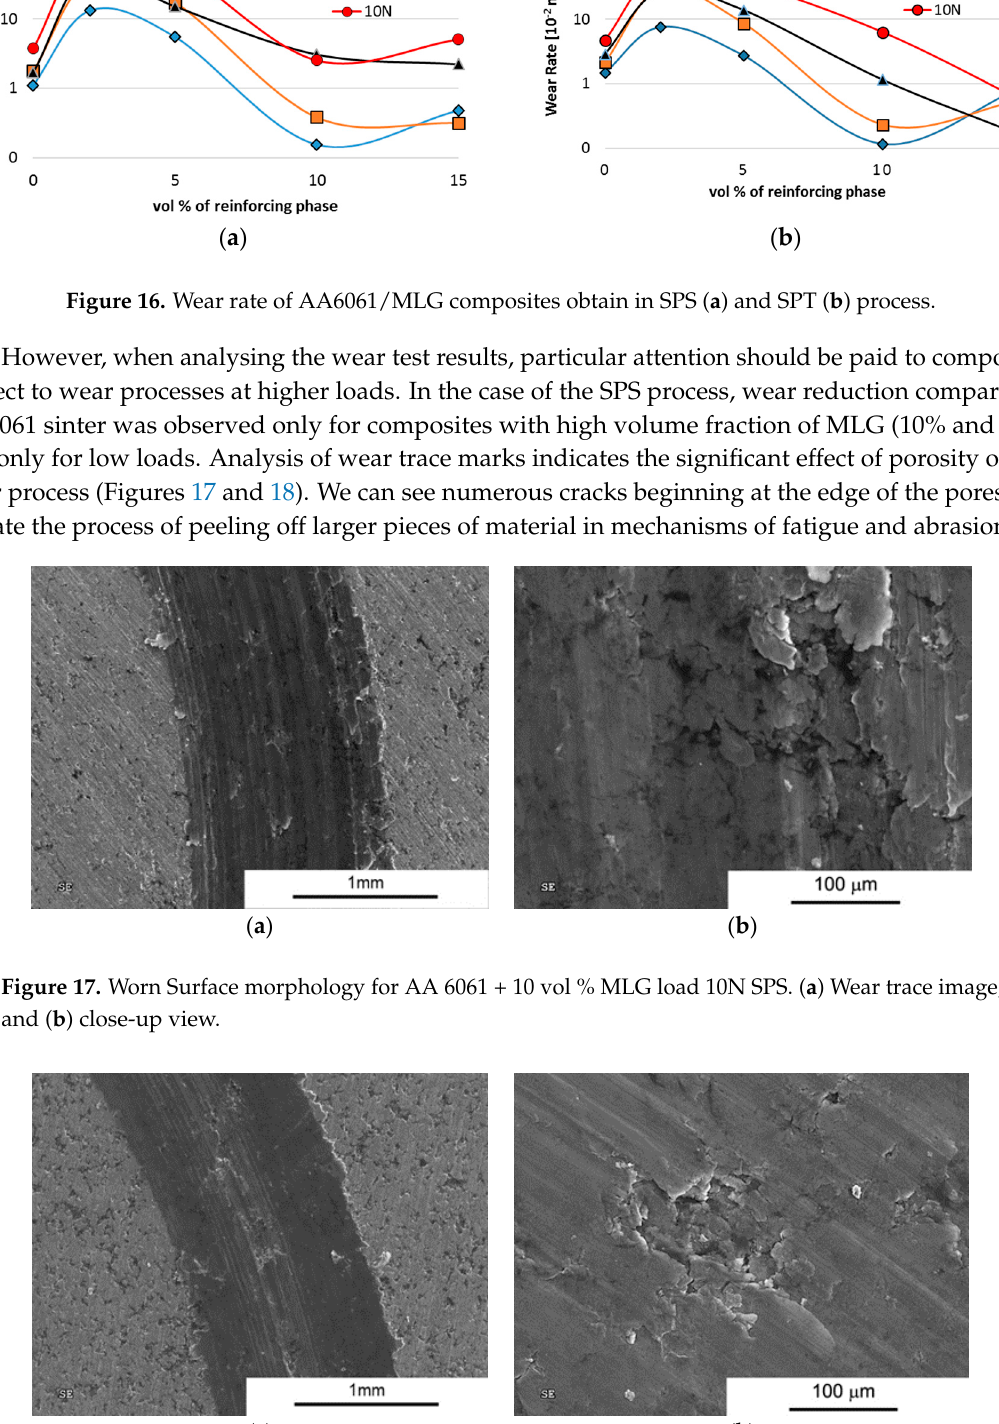
Figure 18. Worn Surface morphology for AA 6061 + 15 vol % MLG load 10N SPS. ( a ) Wear trace image; and ( b ) close-up view.